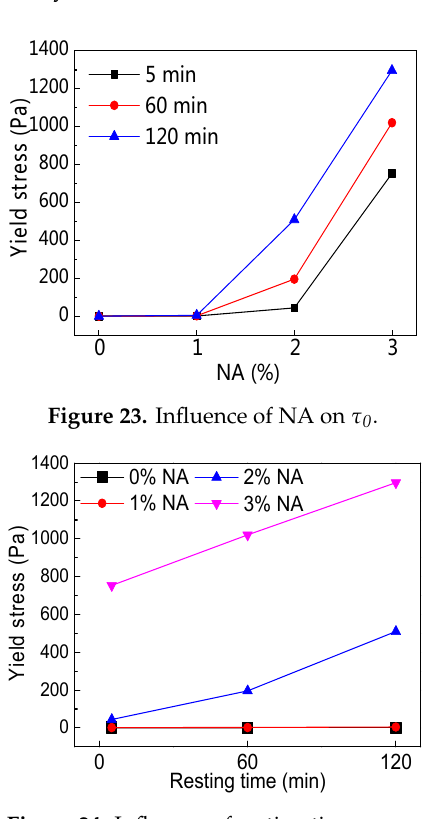
Figure 24. Influence of resting time on τ 0 . Table 6. Rheological parameters of C–FA paste with NA.